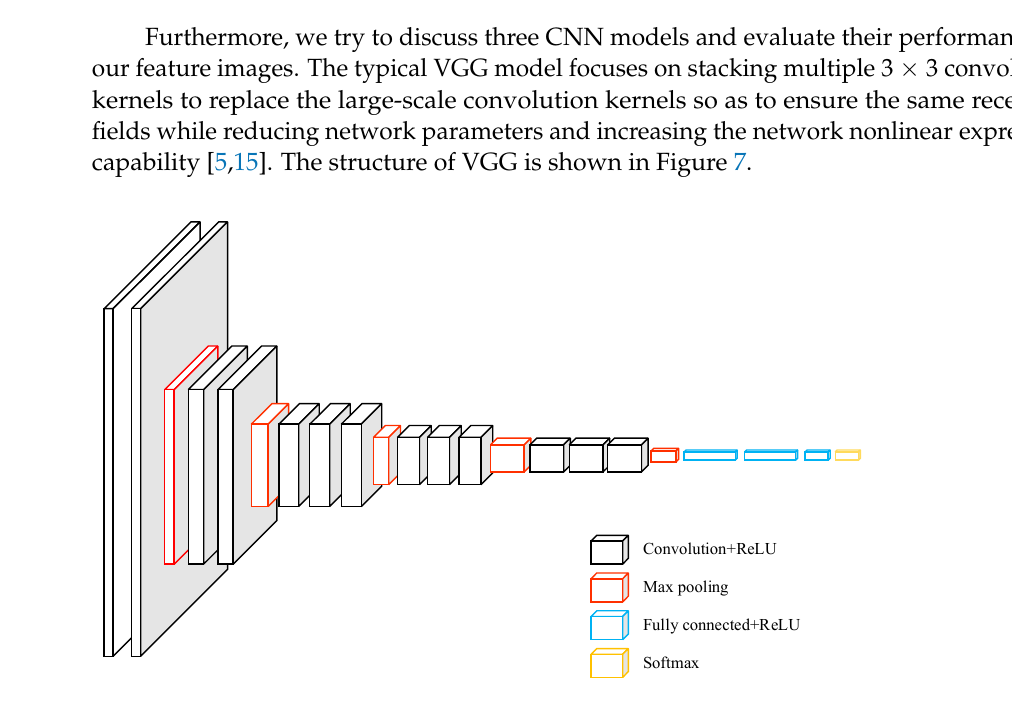
Figure 6. Basic structure of convolution neural network.